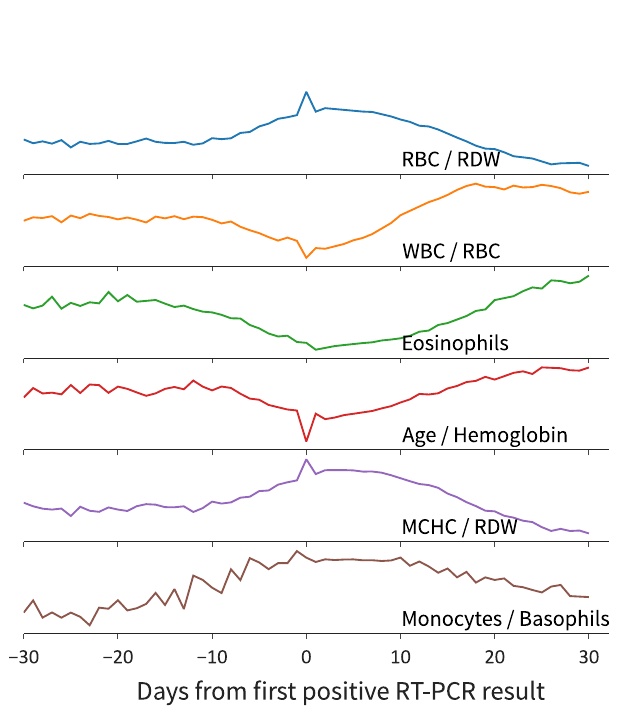
Fig. 1 Analytes average progression through COVID-19 disease course. Average values of the most impactful analytes along with the disease time frame, from 30 days before the fi rst positive RT-PCR result up to 30 days after. N = 120,726